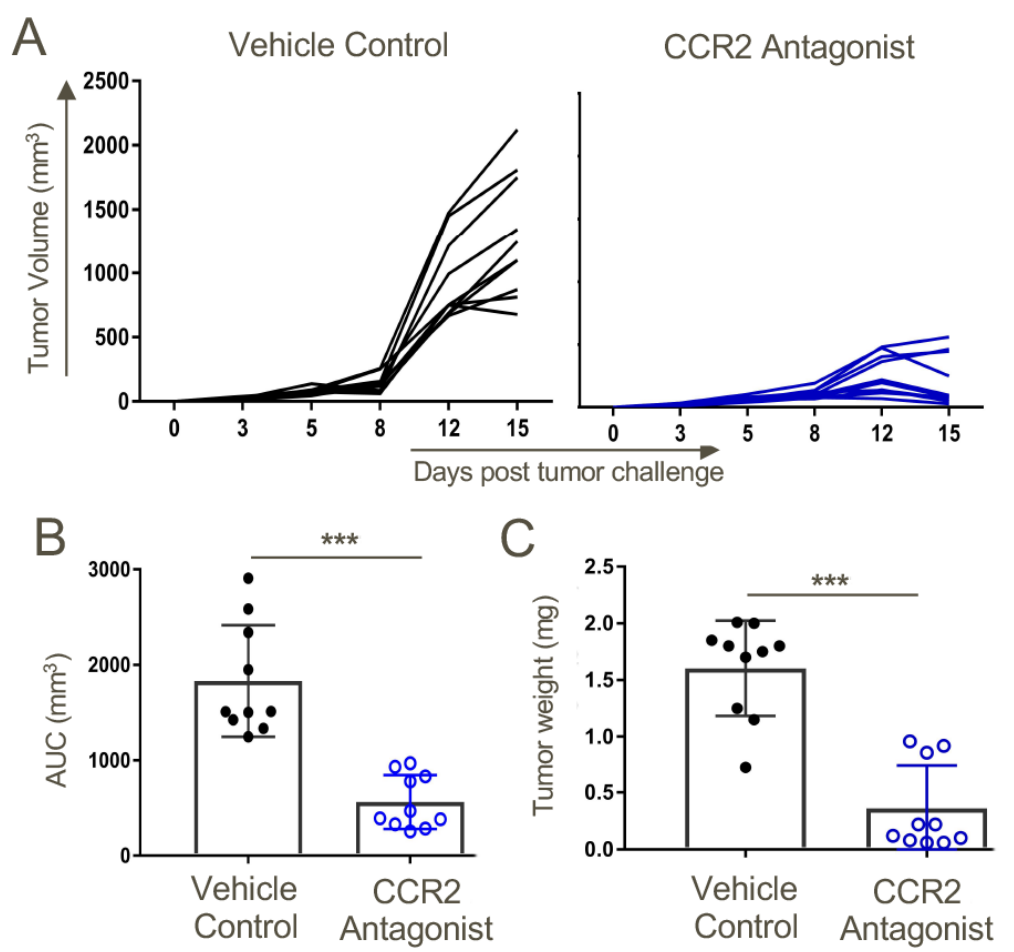
Figure 8. Therapy with a CCR2 antagonist inhibited tumor growth in syngeneic WT mice. Mice were transplanted s.c. with 1.2 × 10 6 TC1 tumor cells. On day 3 post-tumor inoculations, mice were randomly distributed to obtain similar (~20 mm 3 ) average tumor sizes across both groups before starting CCR2 antagonist treatment. Mice were treated twice daily with a 10 mg / kg dose of CCR2 antagonist or vehicle control until the day of harvest on day 15. ( A ) Tumor measurements in response to CCR2 antagonist or vehicle control treatments. ( B ) Area under the curve analysis. ( C ) Tumor volumes on the day of tumor harvest; n = 10 / group and *** p < 0.001. Data are representative of three independent